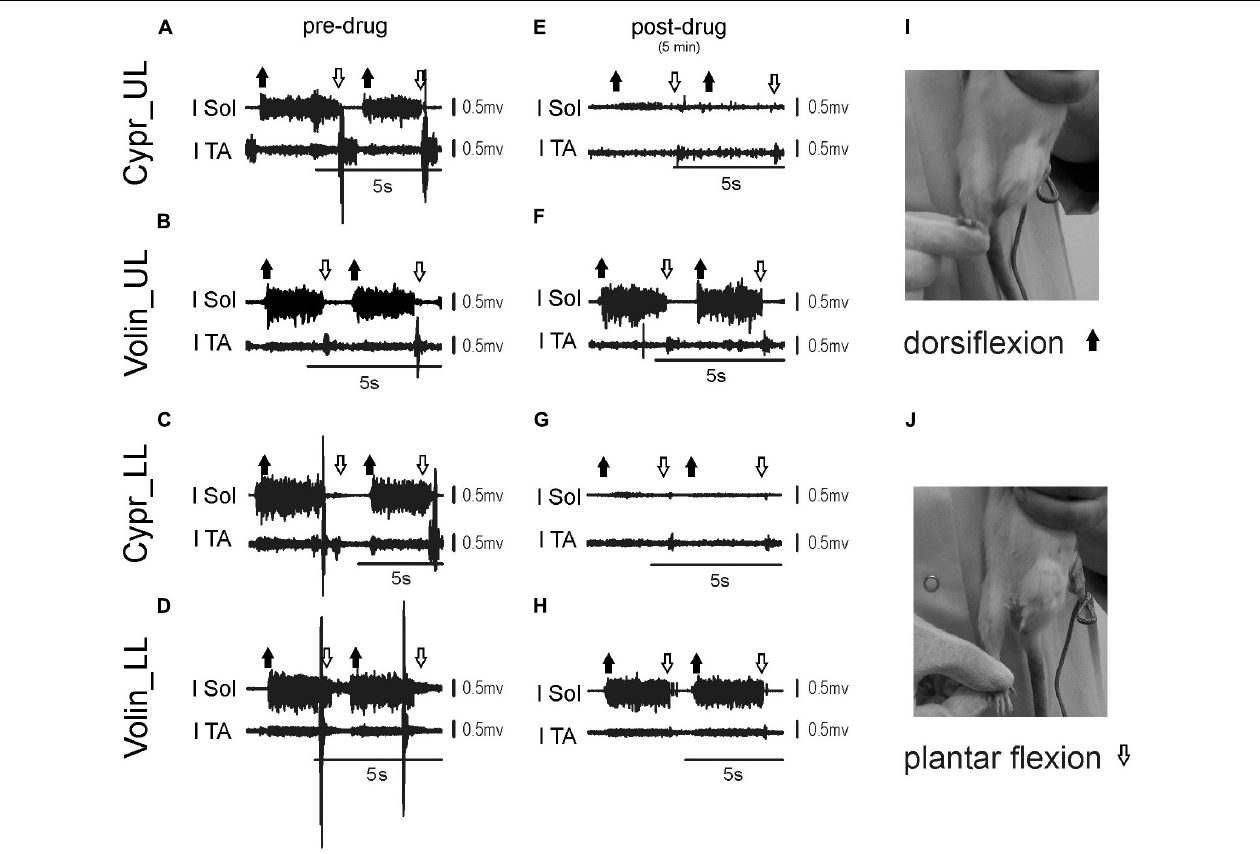
FIGURE 6 | Examples of EMG response of soleus and tibialis anterior muscles to plantar- and dorsiflexion before (A–D) and 3–5 min (E–H) after intrathecal drug application in the upper (UL) and low (LL) lumbar spinal cord. The examples of two consecutive EMG responses confirm stability of stretch reflexes evoked before and after drug applications. Photos in the right panels (I,J) present experimental conditions carried out to induce stretch reflexes in the ankle muscles. Note that on the soleus EMG activity Cyproheptadine but not Volinanserin application had a clear effect. l Sol, left soleus muscle; l TA, left tibialis anterior muscle; Cypr, Cyproheptadine; Volin, Volinanserin; SB 242, SB 242084; SB 206, SB 206553; UL, upper lumbar segments (L2/L3); LL, low lumbar spinal cord